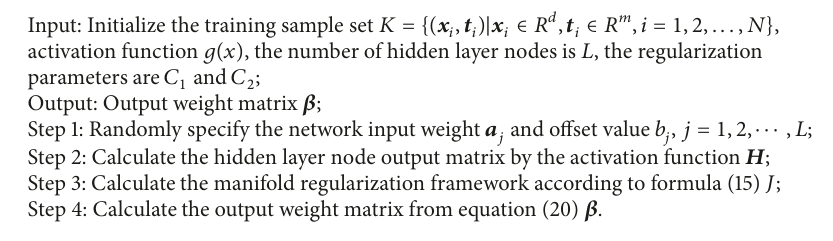
Algorithm 1: GLELM algorithm.